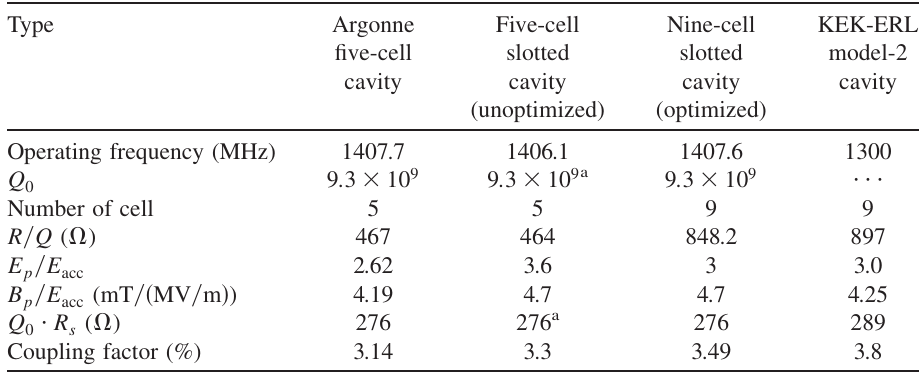
TABLE I. Parameters of the accelerating mode for the ANL and KEK-ERL cavities.